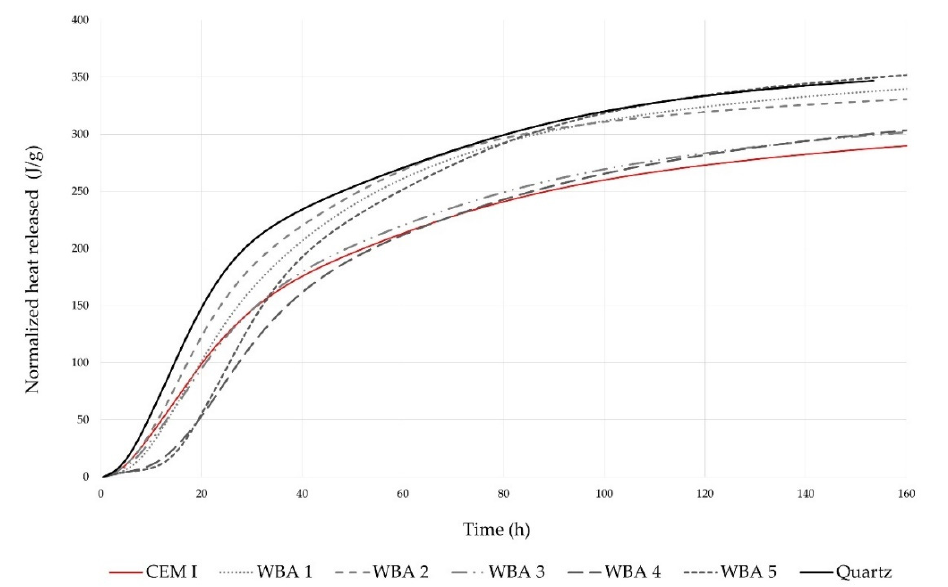
Figure 5. Cumulative heat curves of the reference paste (CEM I) without substitution, pastes with 15 wt% WBA, and paste with 15 wt% quartz, obtained by isothermal